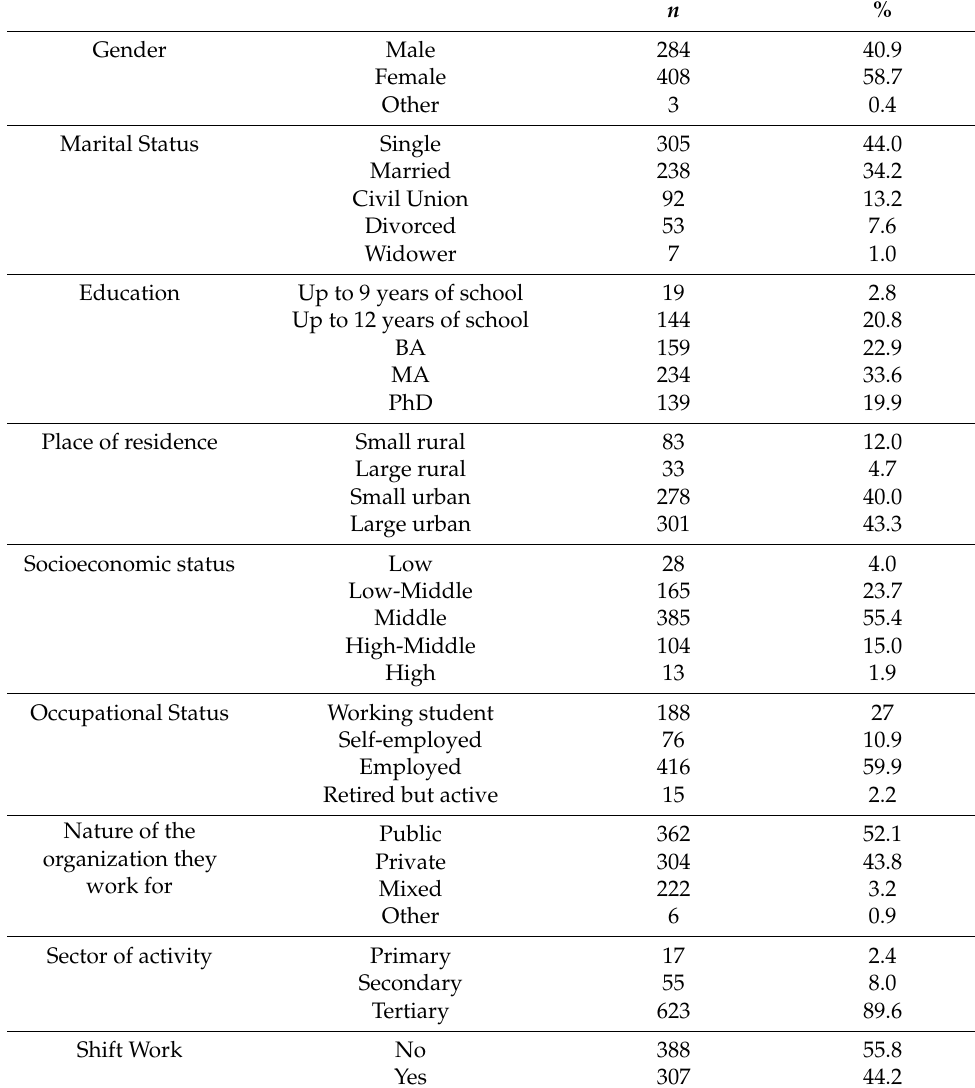
Table 3. Sociodemographic characteristics of the participants ( n = 695; M age = 37.71; SD = 12.64;